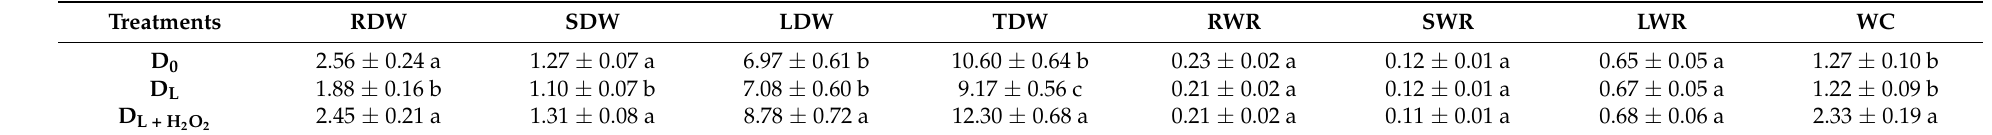
Table 4. Effects of fertigation treatments (D 0 —standard nutrient solution or control treatment, D L —raw leachate treatment and D L + H leaf and total plant dry weight (RDW, SDW, LDW and TDW, respectively) (g), relative root weight ratio (RWR), stem weight ratio (SWR), leaf weight ratio (LWR) (-) and plant water content (WC) (-) in D. deremensis plants at the end of the experiment. The experiment simulates a cascade cropping system with different leachate treatments of Chrysalidocarpus lutescens as primary or “donor” and Dracaena deremensis as a secondary or “acceptor” plant culture. The results are expressed as means ± standard deviation (n = 4). In each column, same letters indicate non-significant differences ( p <